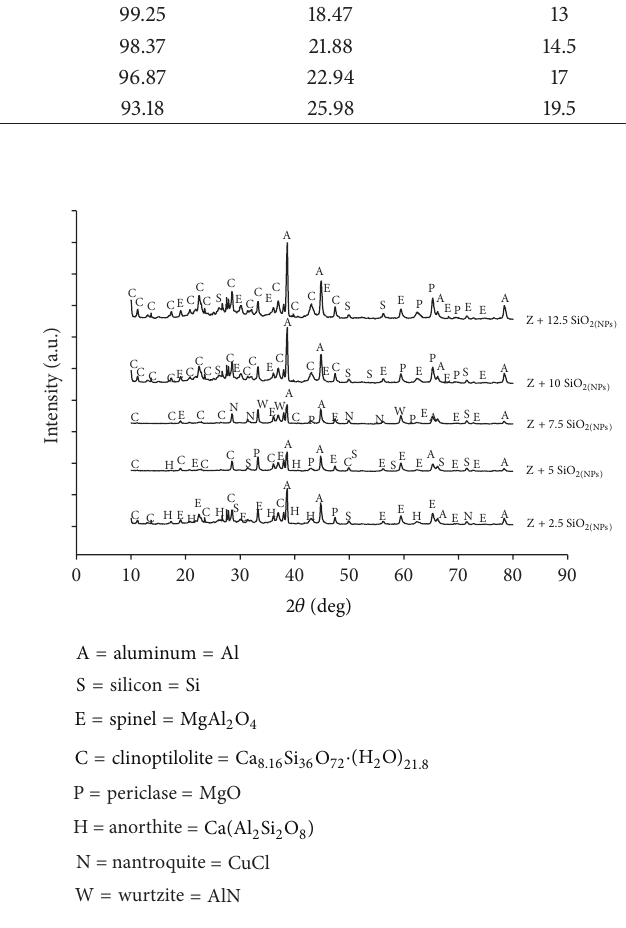
Figure 6: X-ray diffraction patterns of slags from the process where zeolite is with nanoparticles of SiO 2